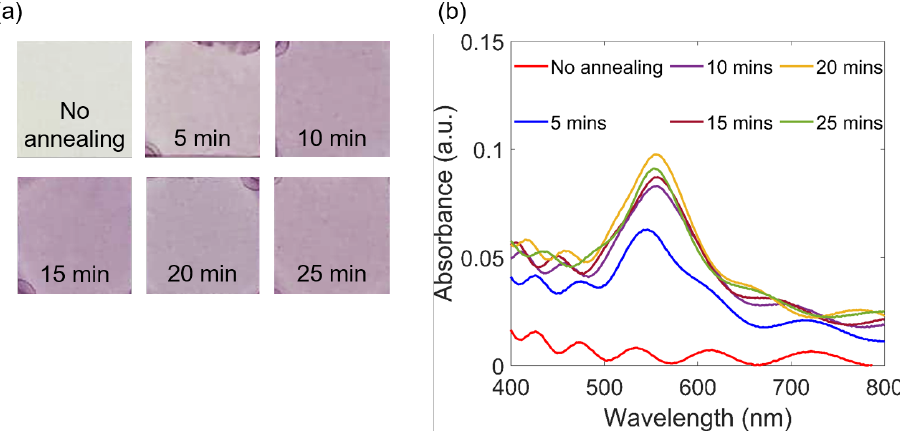
Figure 5. Formation of Au NPs depends on different annealing times: ( a ) Direct smartphone pictures of the nanocomposite samples of SU-8 mixed with 1 wt.% Au salt, obtained by annealing method at 95 ◦ C for different durations. ( b ) The corresponding SPR